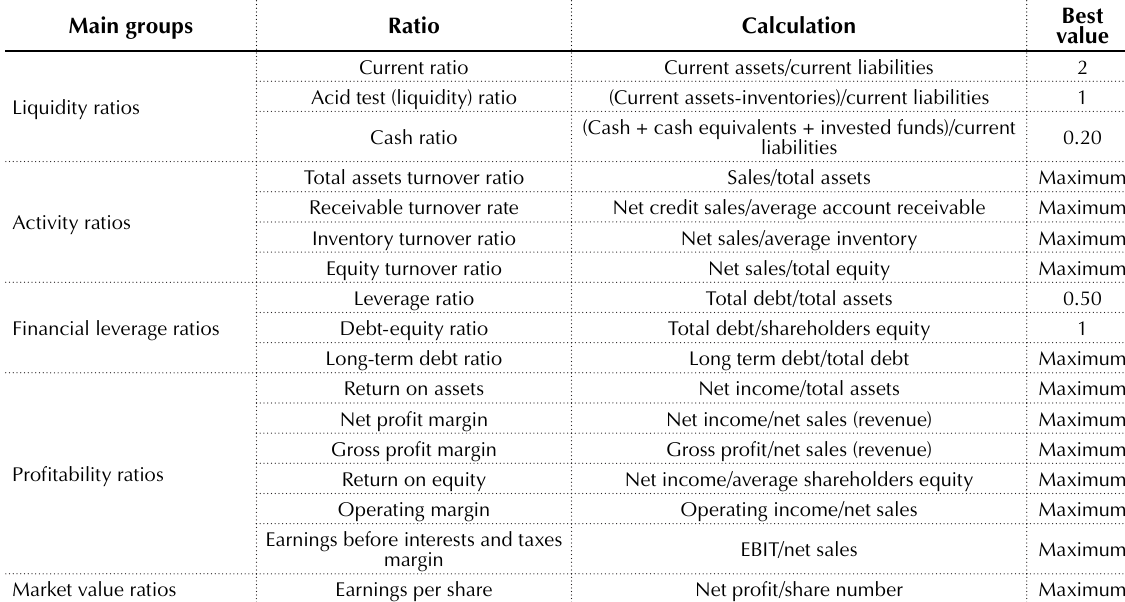
Profitability ratios